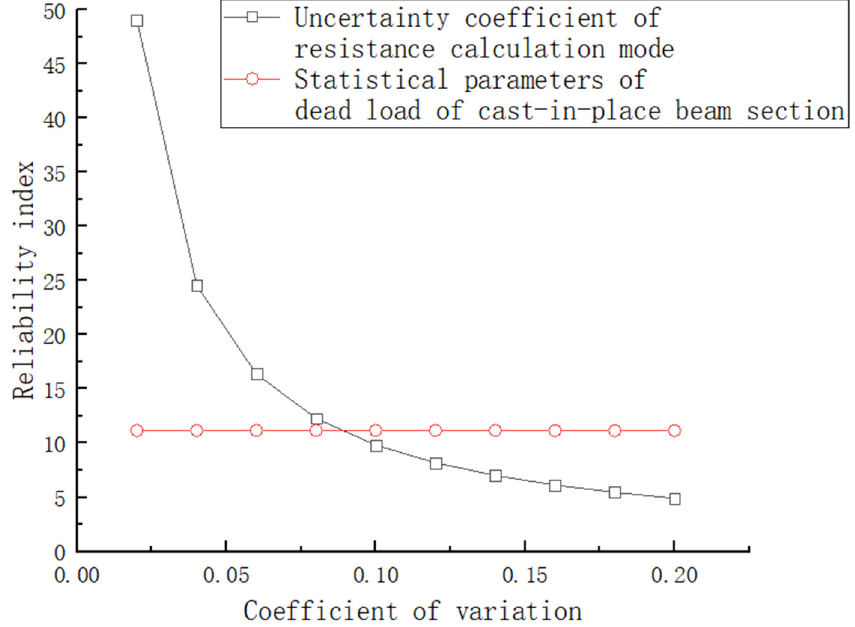
Figure 6. Effect of coefficient of variation of each parameter on stability and reliability index under combination II. combination II.